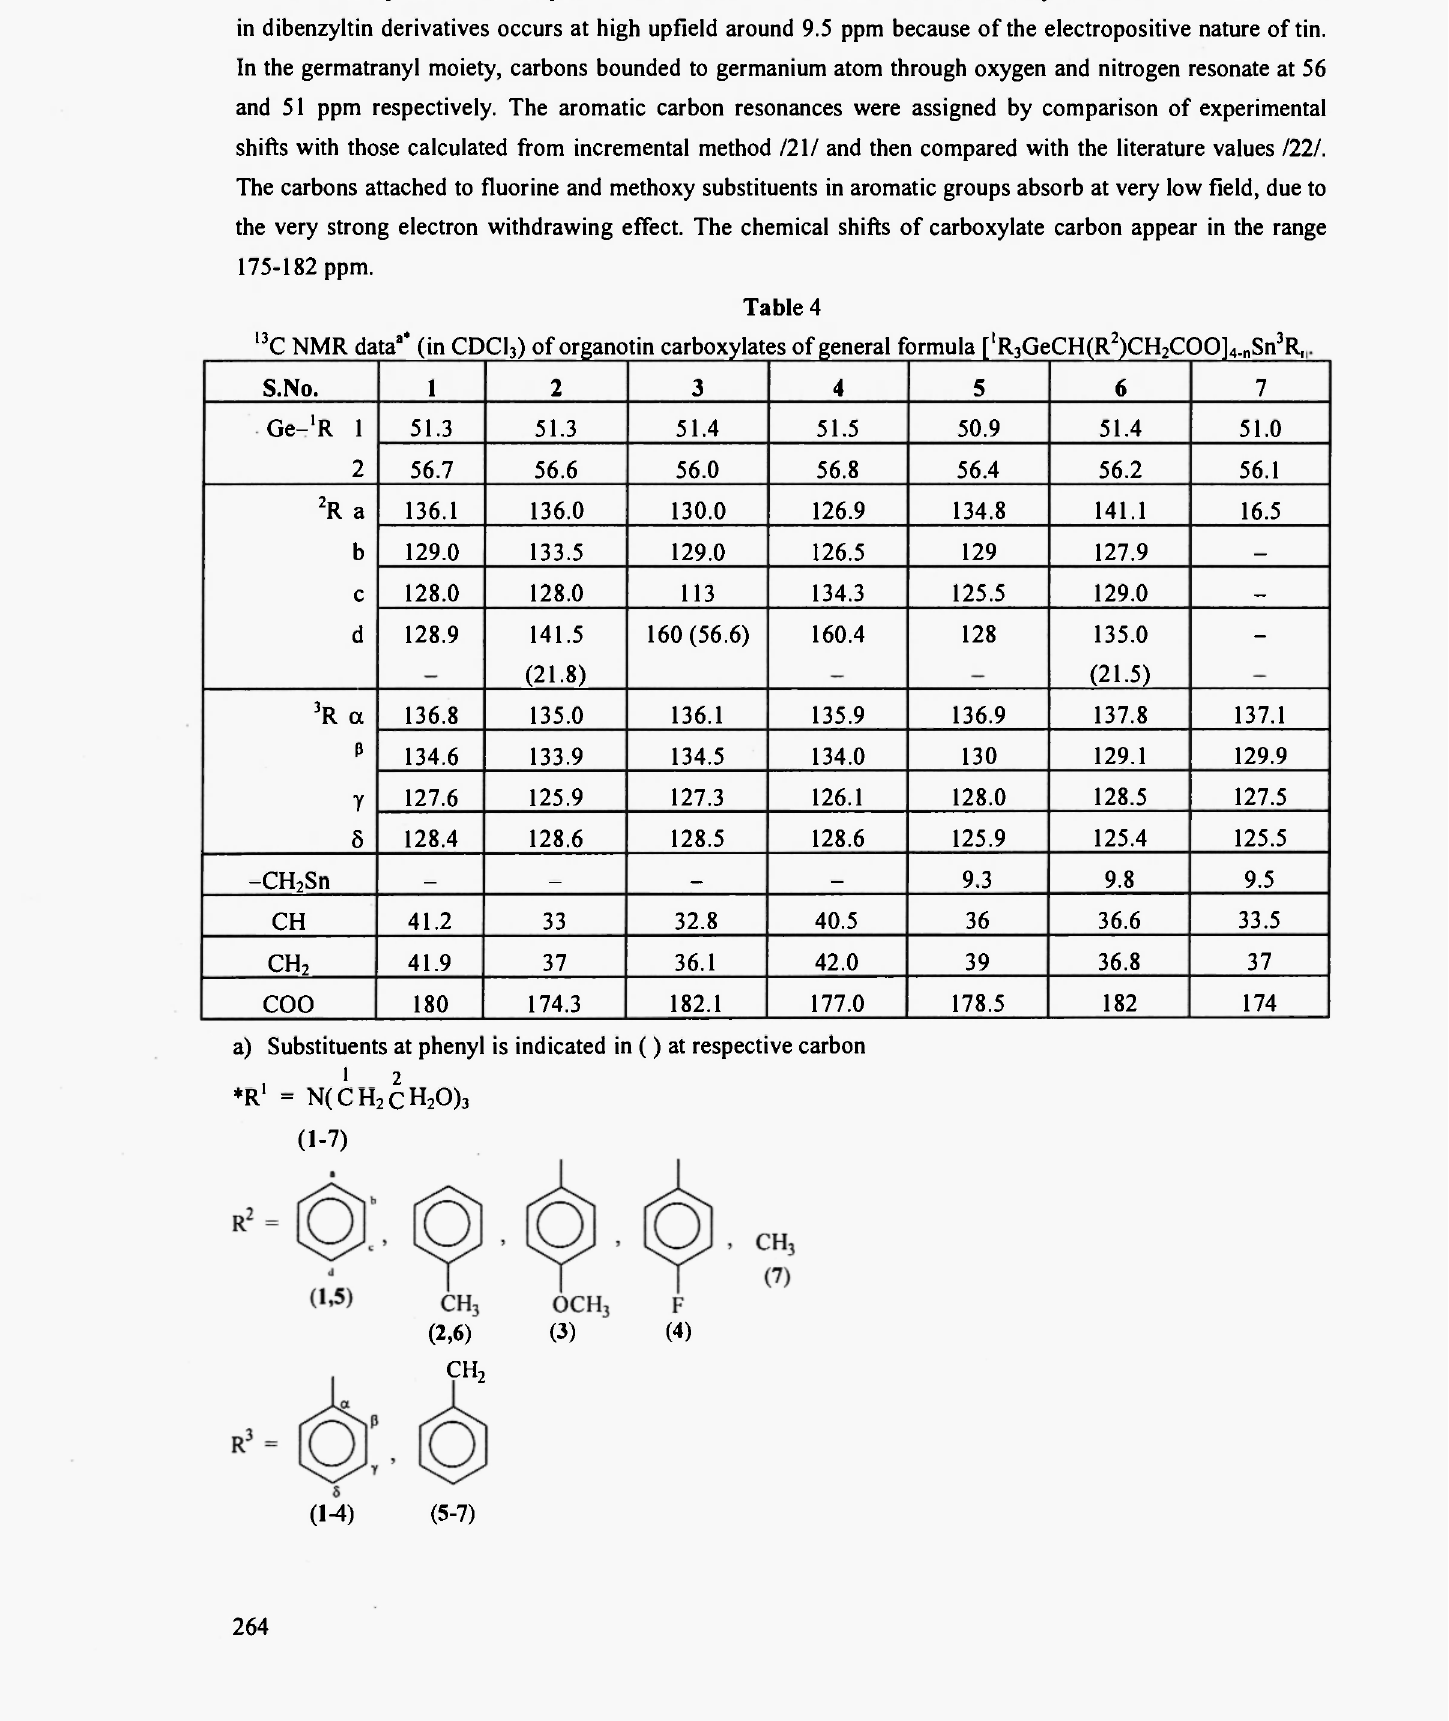
3 ) of organotin carboxylates of general formula [